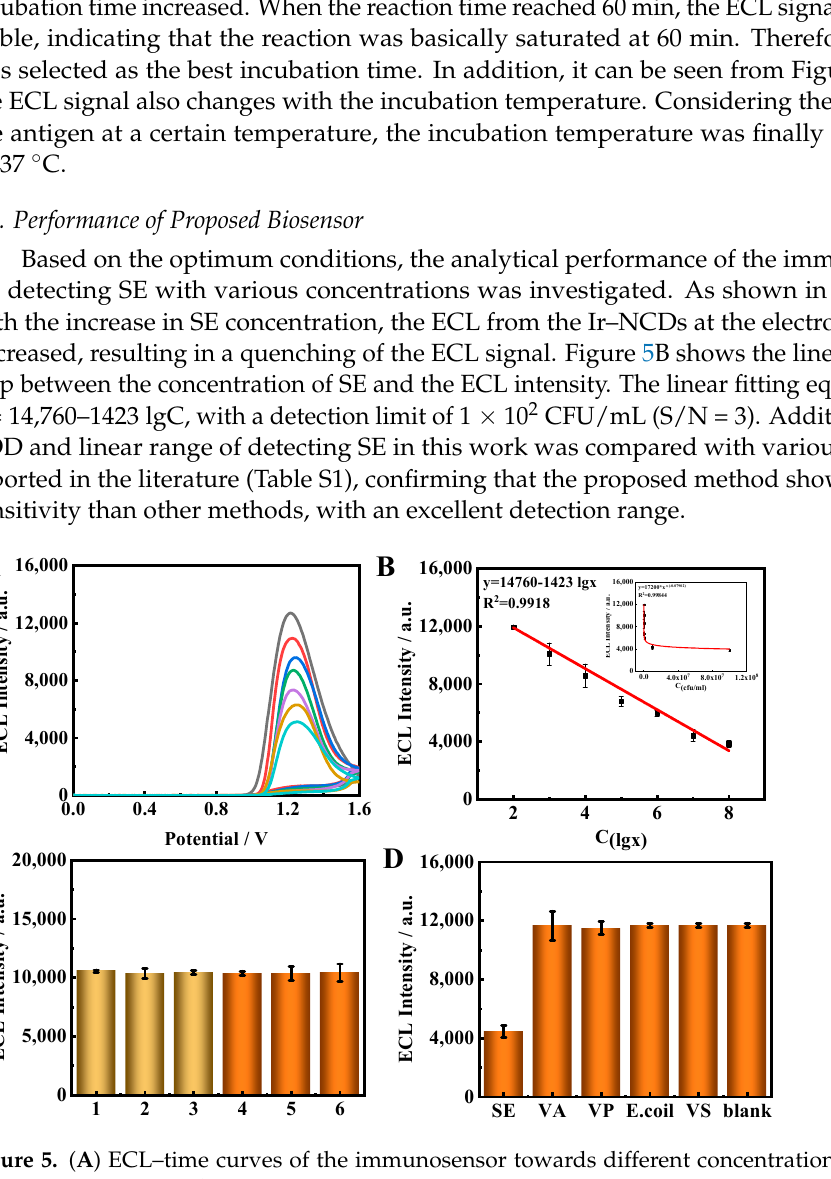
Table 1. Recovery results of spiked salmonella in sheep feces sample. Added (CFU/mL)